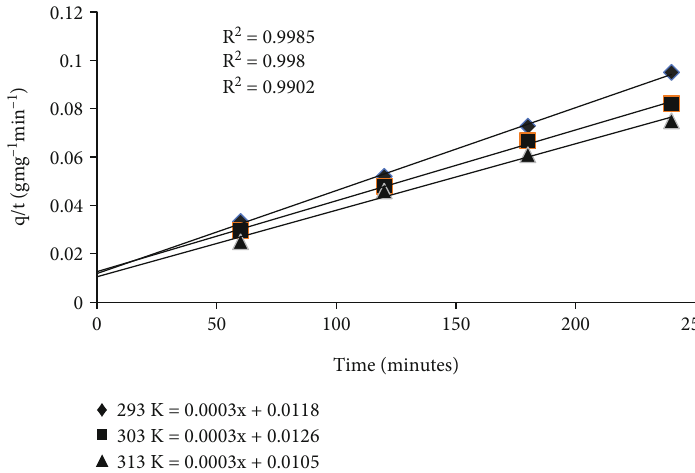
Figure 10: Pseudo-second-order kinetic plot of M.B onto BTW.